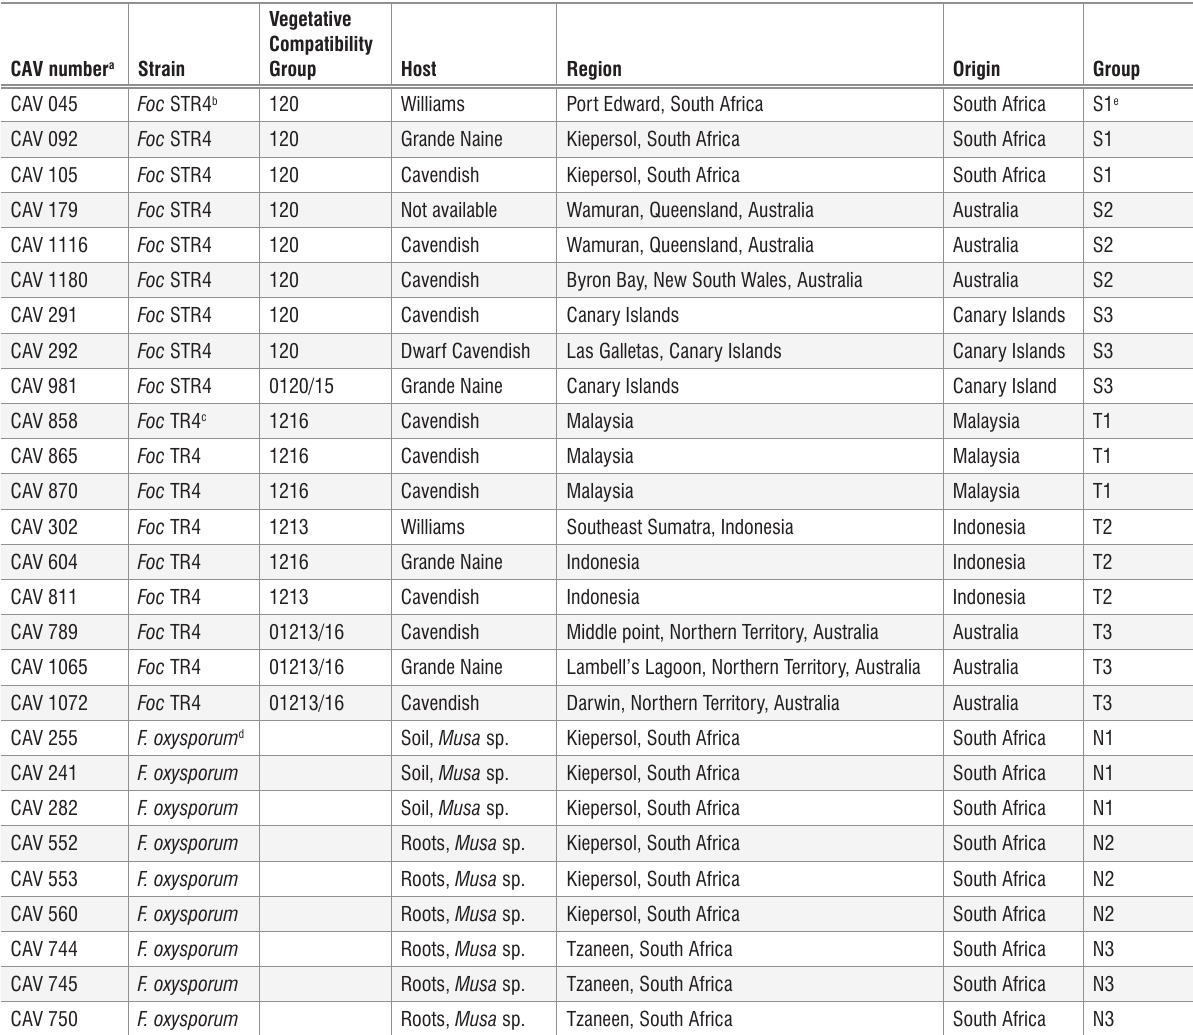
Table 1: Fusarium oxysporum isolates used for cDNA-amplified fragment length polymorphism and reverse transcription real-time quantitative PCR analysis